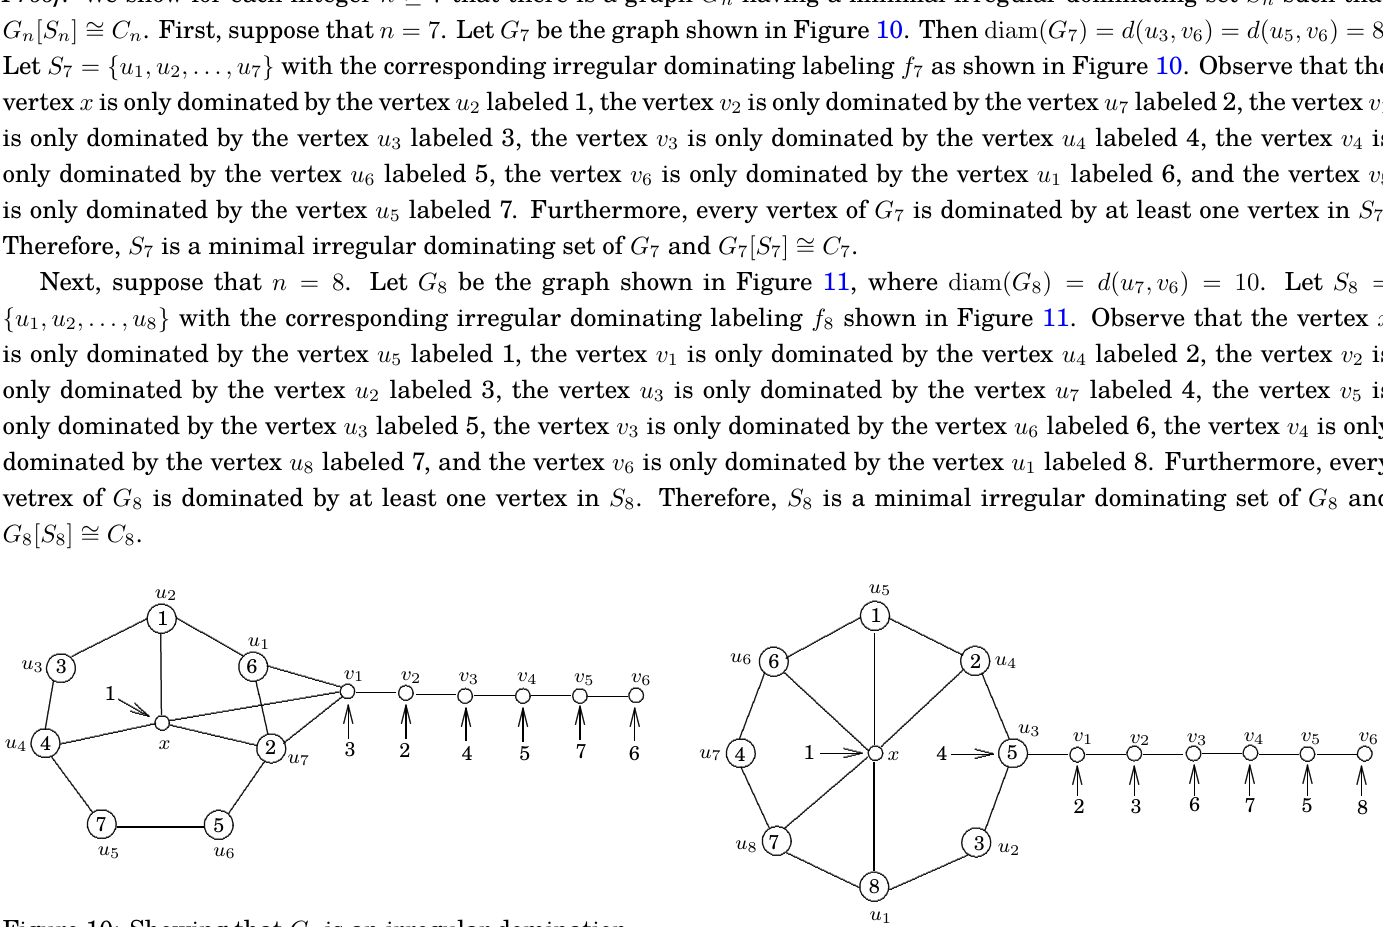
is an irregular domination 8